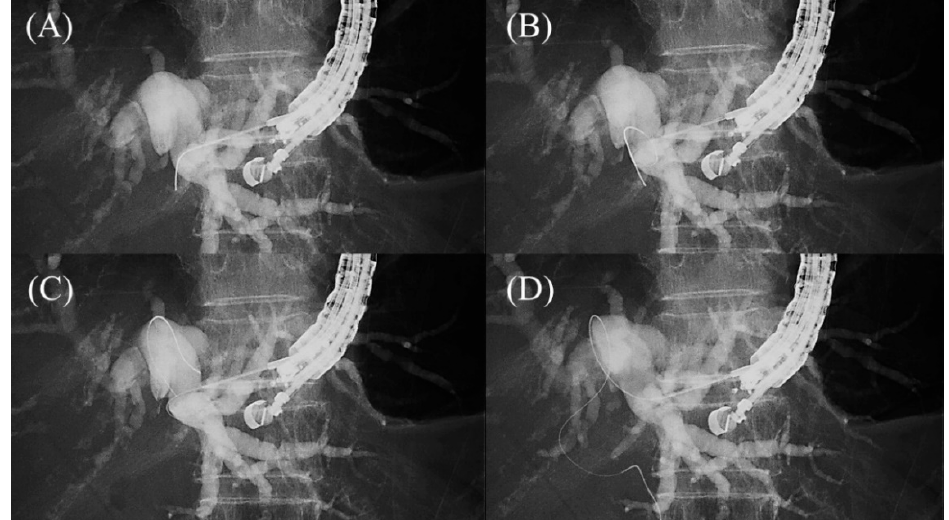
Figure 10. Loop technique for redirection of a guidewire. If a guidewire is unintentionally advanced to the peripheral side, push the guidewire with rotation. When the tip of the guidewire is caught on a lateral branch ( A ), the guidewire will bend and form a loop by pushing force ( B ). If the loop is facing the hilar region, the guidewire can be advanced to the hilum by pushing further ( C , D ).